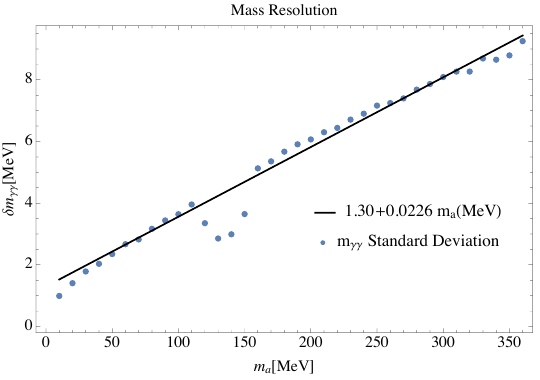
Figure 4 . The resolution function and standard deviation in the di-photon invariant mass for K L ! (cid:25) 0 a . In calculating the standard deviation, samples after CUT10 and after the requirement of correct pairing and vertex choice are used. The linear (cid:12)t is performed excluding the pion mass region, 120 MeV (cid:20) m a (cid:20) 150 MeV where CUT10 cannot be